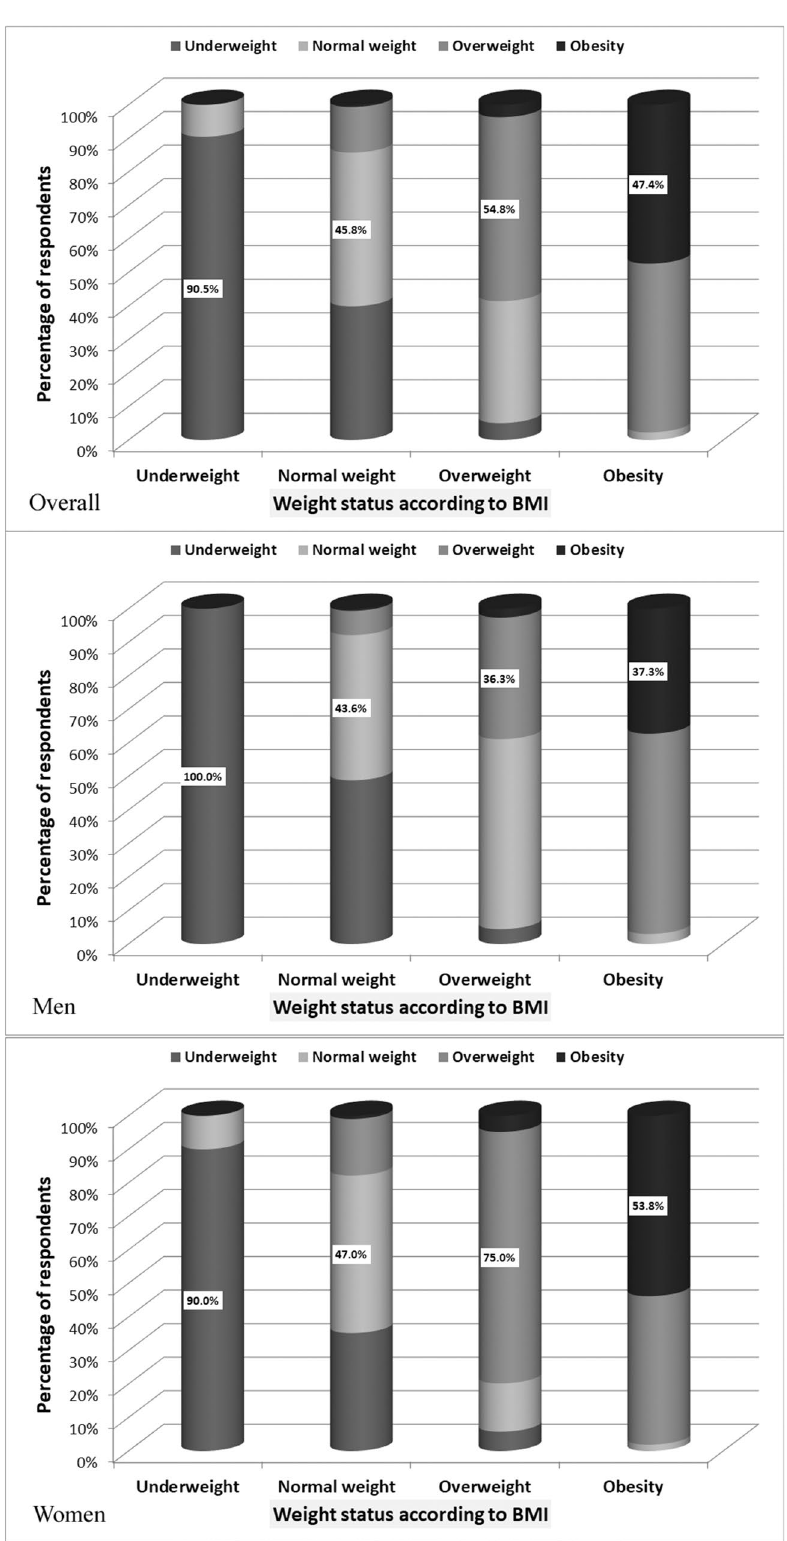
Figure 2. Comparison of compliance between subjective assessment of weight status according to Figure Rating Scale and weight status based on the